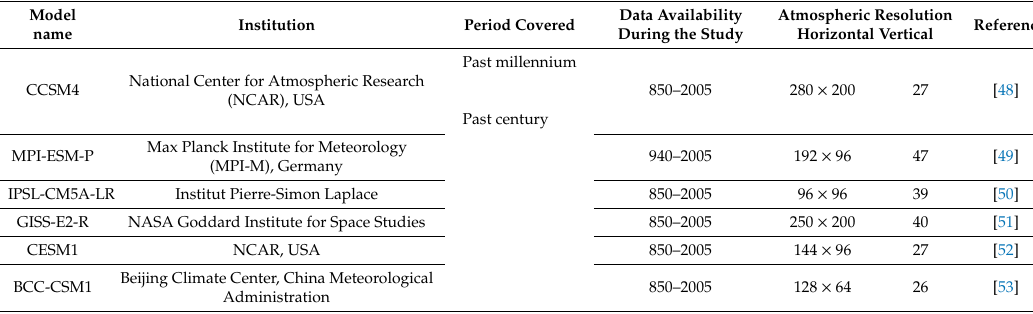
Table 2. Modelling centers, characteristics, and references of Coupled Model Intercomparison Project (CMIP5) models used in this